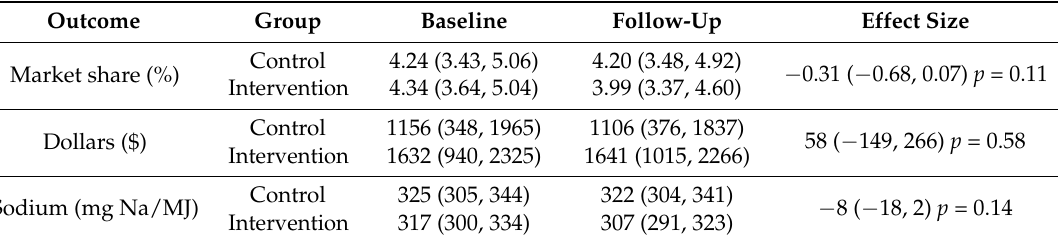
Table 2. Study outcomes at baseline and follow